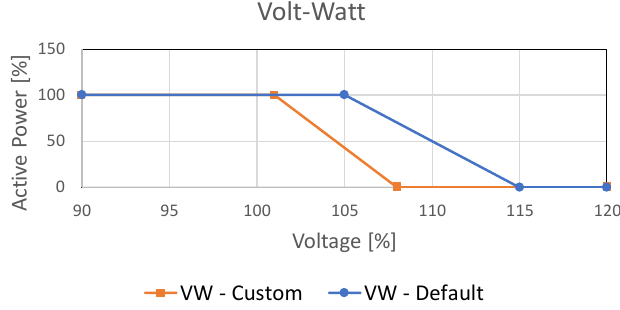
Figure 9. Volt-Watt curves used in this study (Default and Custom).